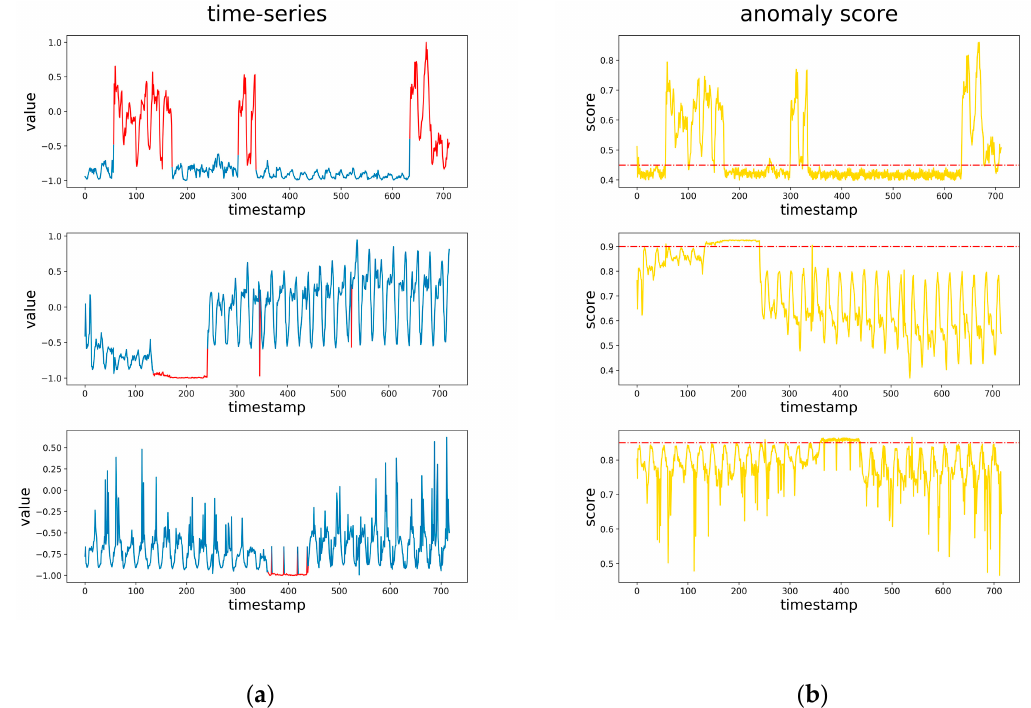
Figure 5. ( a ) The original time series containing anomalies, and the red parts are anomalies. ( b ) The anomaly score corresponding the time series in part a, and the dotted line is the optimal